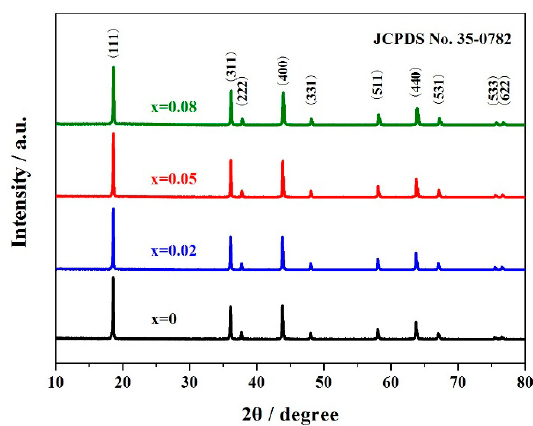
Figure 1. XRD patterns of LiCu x Mn 1.95 − x Si 0.05 O 4 (x = 0, 0.02, 0.05, 0.08) samples.